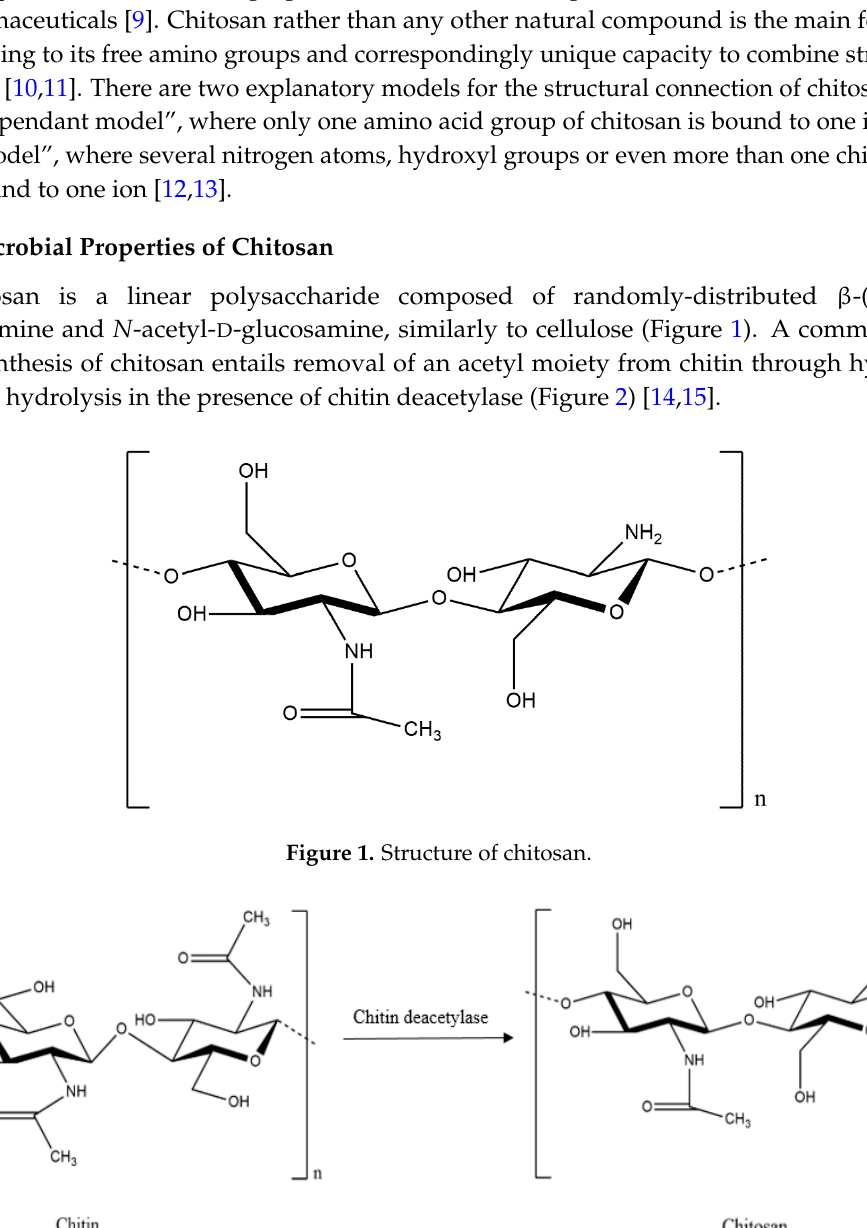
Figure 2. Deacetylation of chitin to chitosan.